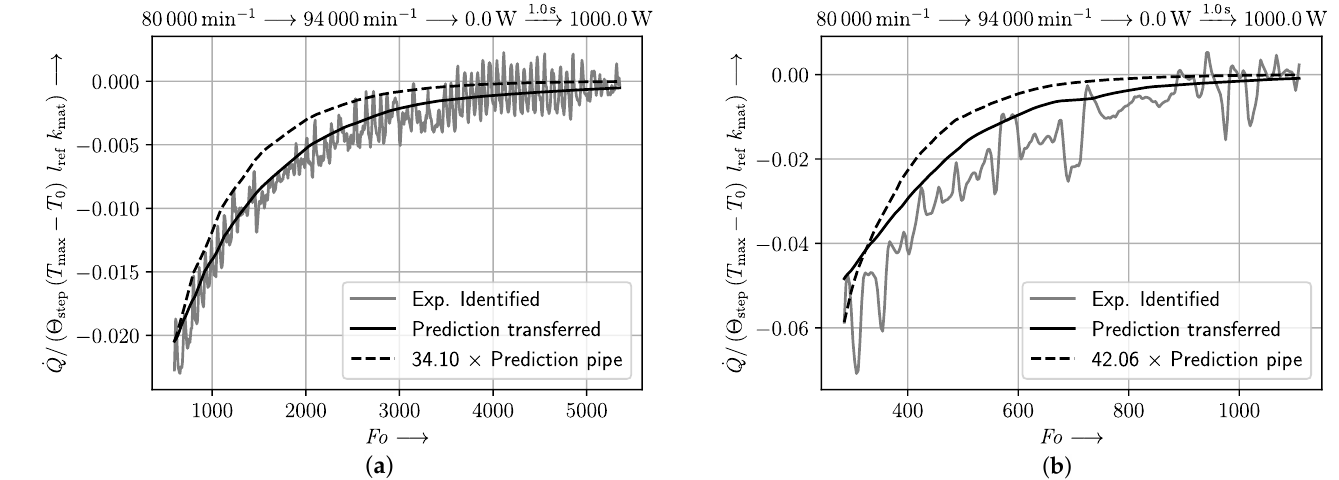
Figure 12. Comparison of experimentally-identified non-dimensional transient heat flow to scaled non-transferred network, that encodes the thermal transient of a pipe and to transfer-learned network for ( a ) compressor and ( b ) turbine, experimentally-identified step response